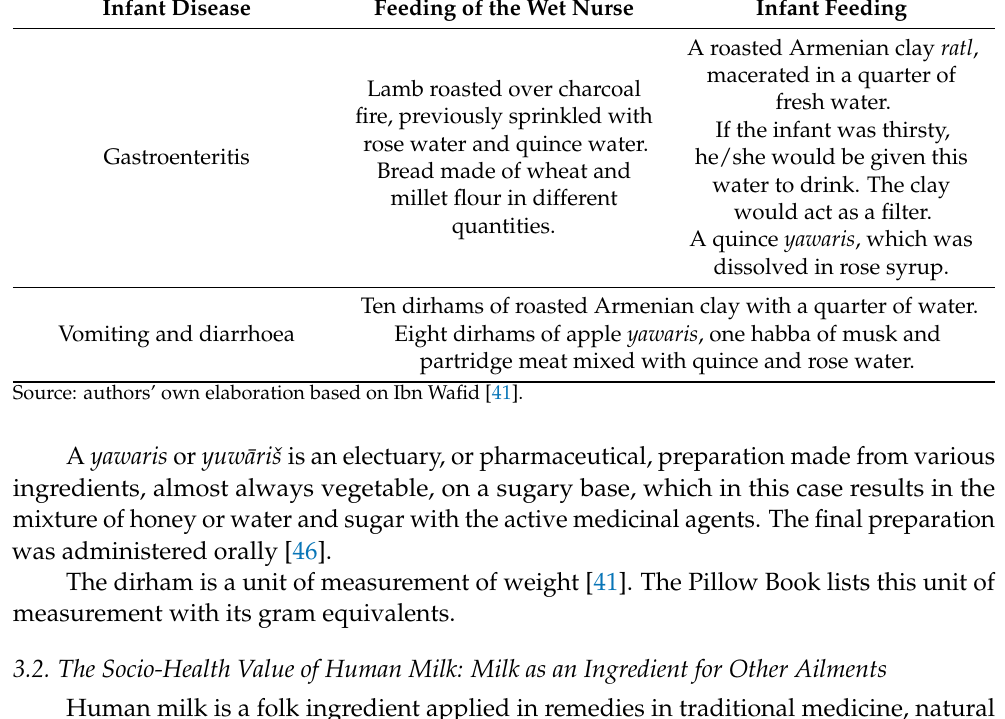
Gastroenteritis